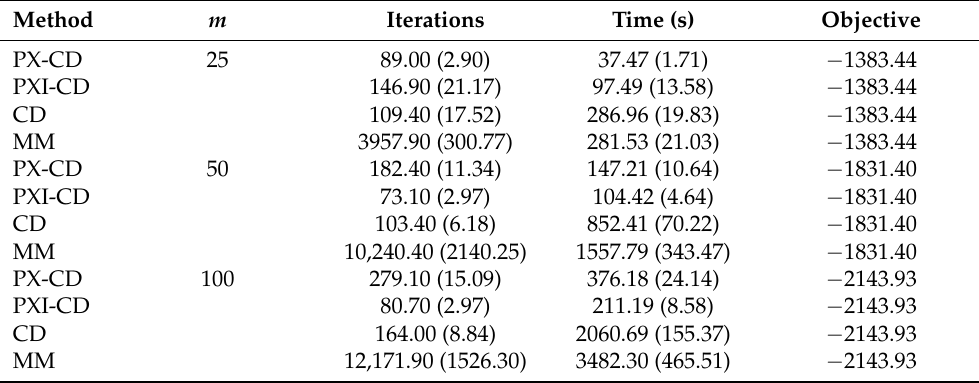
Table 4. The convergenceresults when V i are full-rank, n = 1000, and γ 0 =